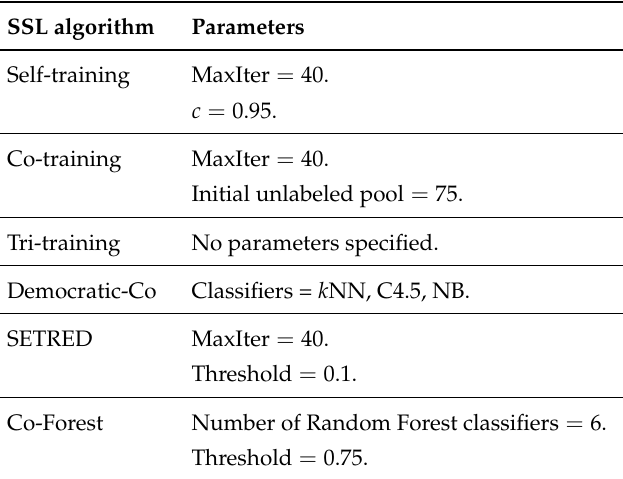
Table 1. Parameter specification for all SSL